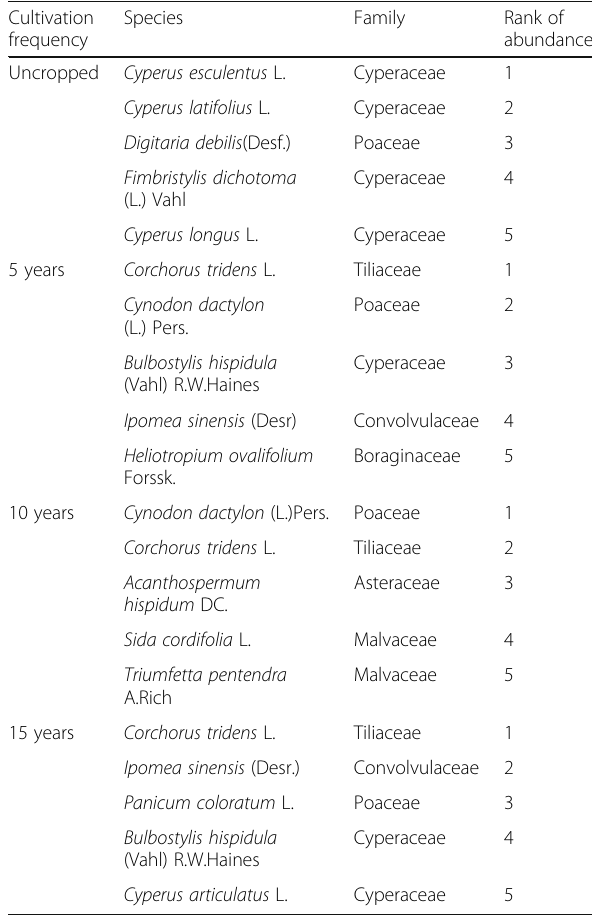
Table 2 Five most abundant weed species at each cultivation frequency Cultivation